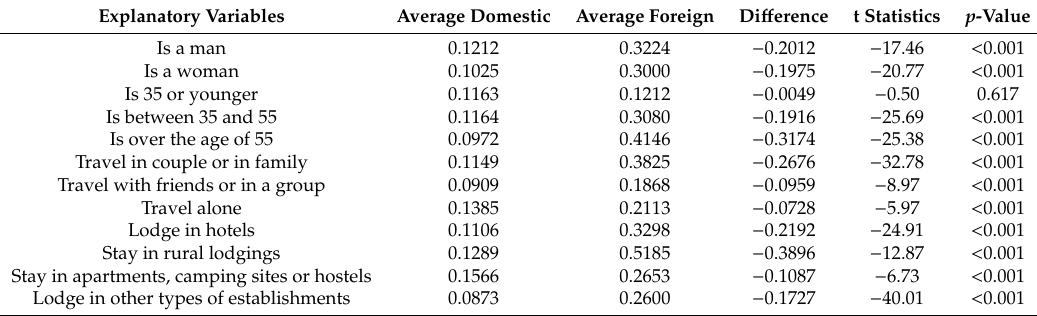
Table 5. T-tests of equality of estimated probabilities of going birdwatching for national tourists and foreign